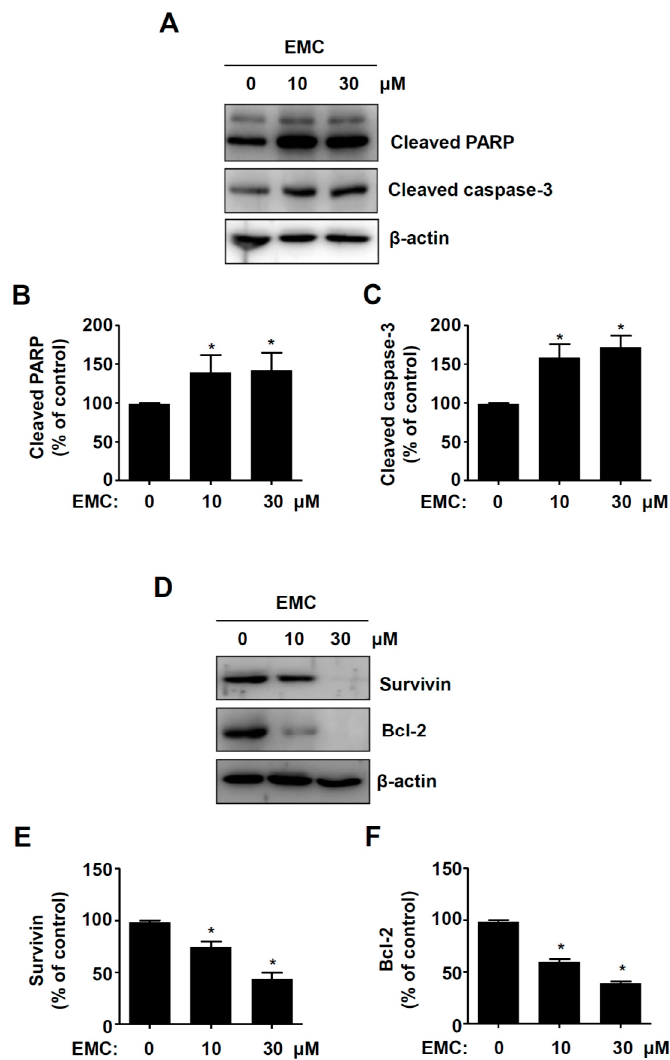
Figure 3. EMC induces apoptotic cell death in pre-osteoblasts. ( A – C ) Pre-osteoblasts were treated in the absence and presence of EMC for 24 h. They were analyzed by western blot analysis with antibodies against the cleaved PARP and caspase-3 ( A ). β -actin was detected on the same sample to normalize the number of lysates. The levels of the cleaved PARP ( B ) and caspase-3 ( C ) were represented as relative percentages of the control. ( D – F ) The cells were analyzed by western blot analysis using Survivin and Bcl-2 antibodies ( D ). After normalization by β -actin, the levels of Survivin ( E ) and Bcl-2 ( F ) were represented as relative percentages of the control. The data are expressed as the mean ± S.E.M. of experiments. * ( p < 0.05) indicates statistically significant differences compared to the control.